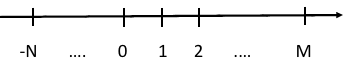
Figure A1. Project